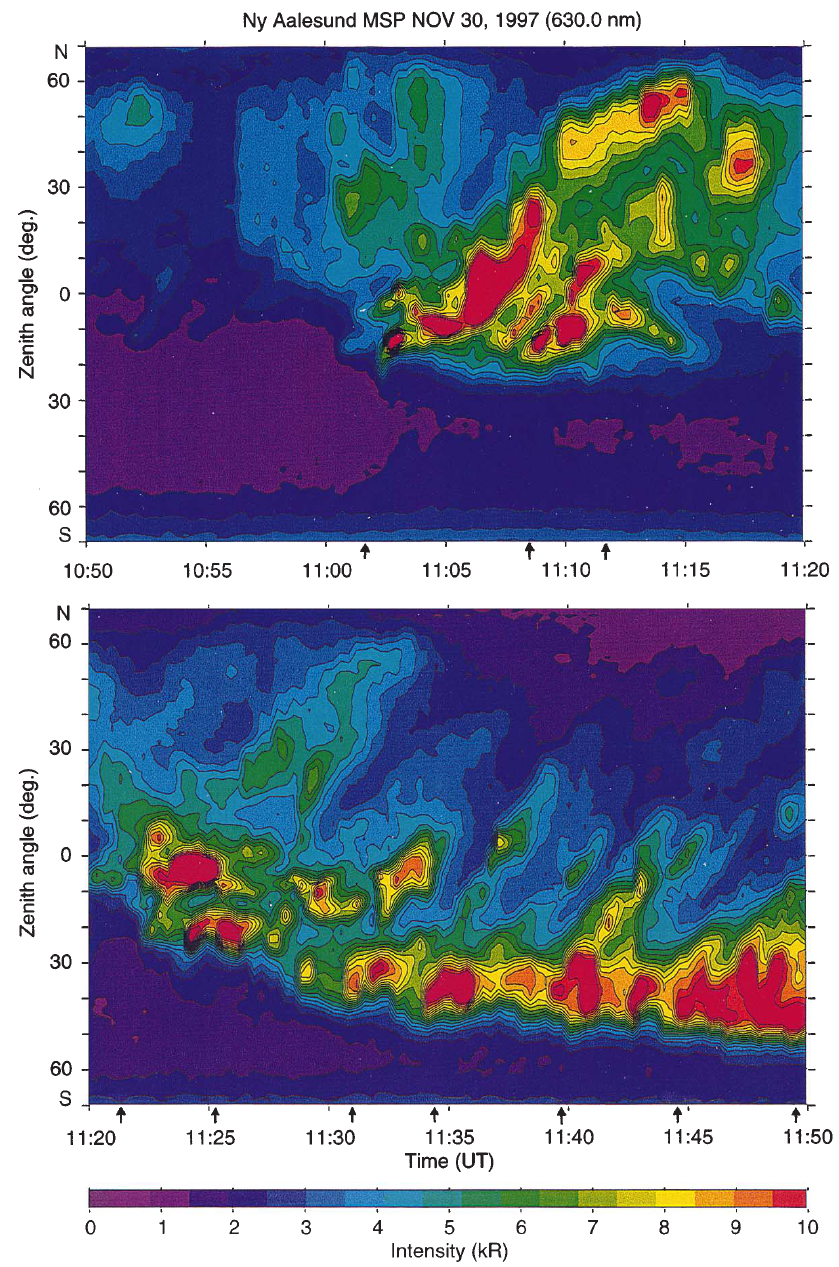
Fig. 3. Color-coded contour plot of Ny A˚ lesund meridian scanning photometer (MSP) observations at 630 nm for the interval 1050–1150 UT on November 30, 1997. Arrows along the horizontal axis mark ground magnetic deflections (see